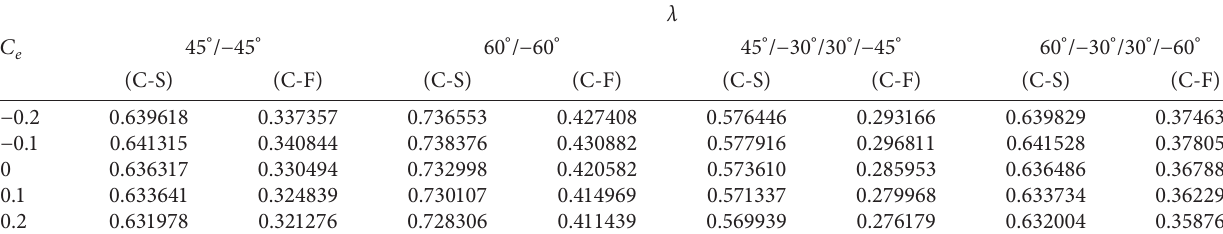
Table 6: Fundamental frequency parameter value with exponential variation in thickness for different support conditions. C